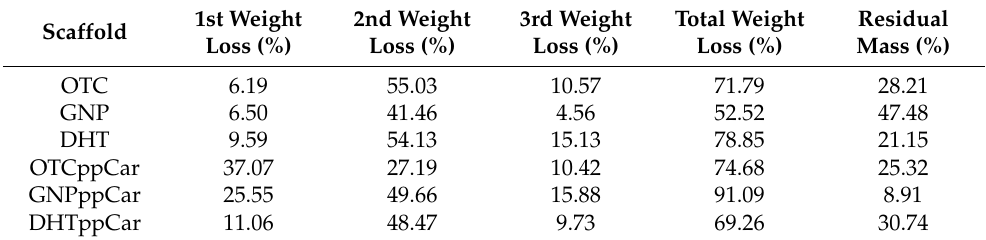
Table 1. Weight loss profile of scaffolds from TGA.